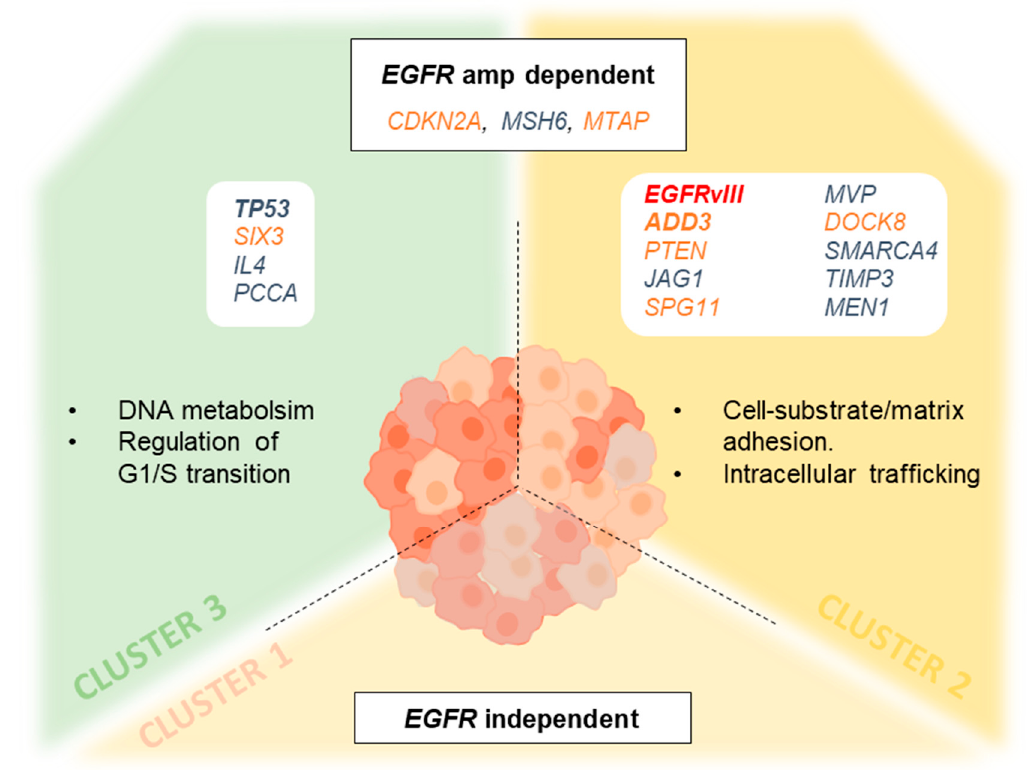
Figure 4. Pathways outlined by clustering analysis. The introduction of genes that differentially contributed to the clusters on the STRING database analysis platform offered a variety of genetic pathways and processes that were especially damaged in C2 and C3. Genes in blue displayed gains, genes in orange displayed losses, EGFR vIII includes loss from exons 2–7. Genes in bold were the most distinctive among the clusters. It needs to be mentioned that MSH6, in addition to gains, showed losses in < 10% of the cases. The main difference between C2/C3 and C1 is that on C1, EGFR alterations were found only in half of the cases. Despite C2 and C3 share some alterations, the downstream connections lead to a subtly quickest disease on C2 compared to the slowest situation on C3.